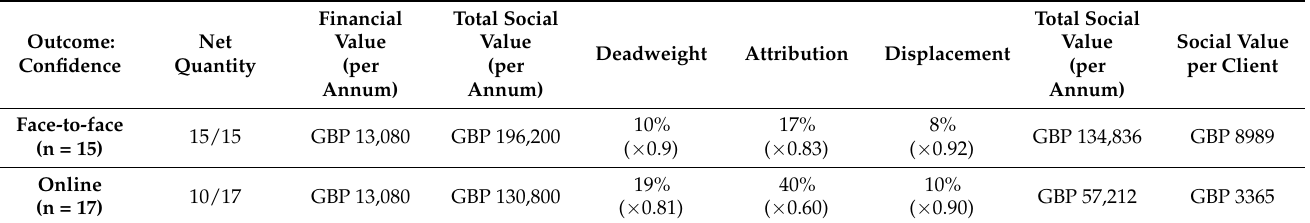
Table 6. Quantity of outcomes and social value for high confidence